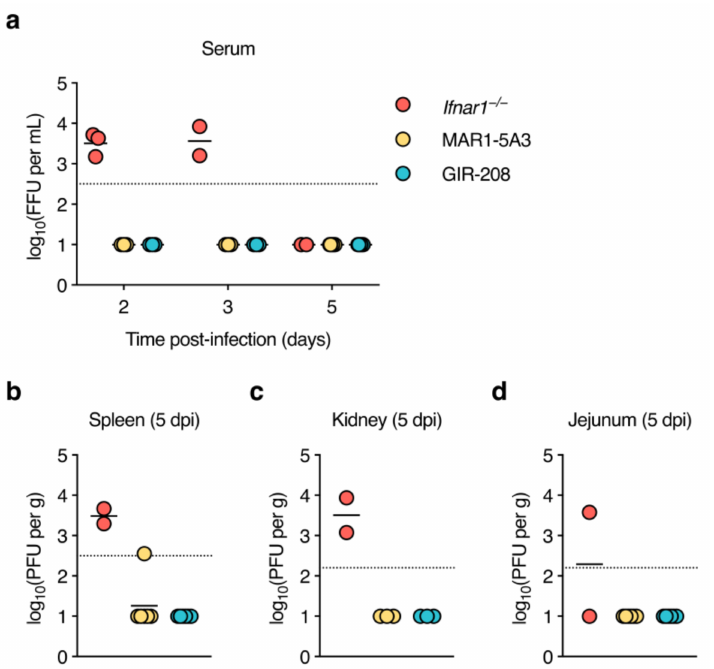
Figure 2. Infectious virus is undetectable in sera and organs of D2Y98P-infected adult wild-type mice treated with IFNAR1-blocking antibody. Ifnar1 − / − mice ( n = 4), MAR1-5A3-treated C57BL/6J mice ( n = 6), and GIR-208-treated C57BL/6J mice ( n = 6) were inoculated subcutaneously with 10 6 PFU of D2Y98P. ( a ) Sera were collected from alternate animals of the same group at 2 and 3 dpi and from all surviving animals at 5 dpi, and infectious virus was measured by focus-forming assay. ( b – d ) Organs were harvested at 5 dpi and infectious virus was measured by plaque assay in spleen ( b ), kidney ( c ), and jejunum ( d ). Each symbol represents one mouse. Short horizontal lines indicate means. Dotted horizontal lines indicate the limit of detection. Data below the limit of detection were assigned nominal